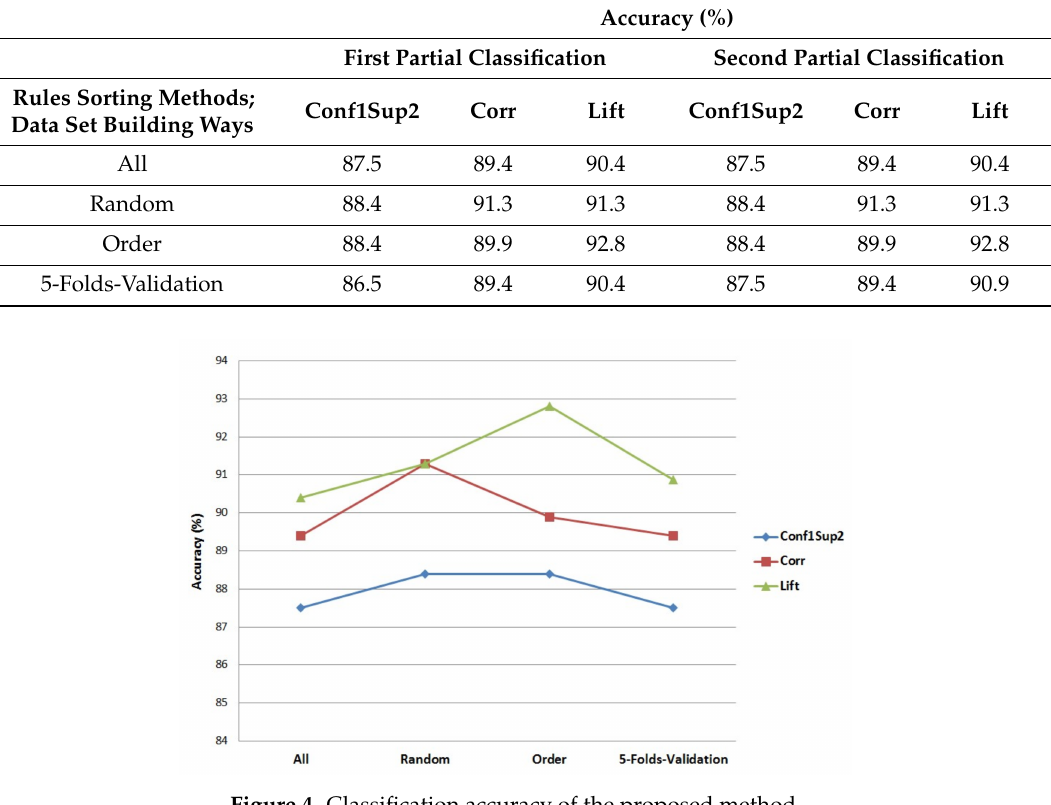
Figure 4. Classification accuracy of the proposed